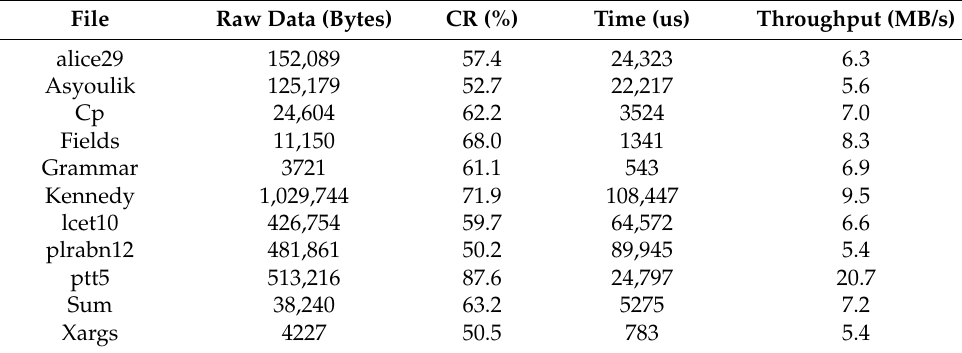
Table 3. Decompression performance on the Canterbury corpus